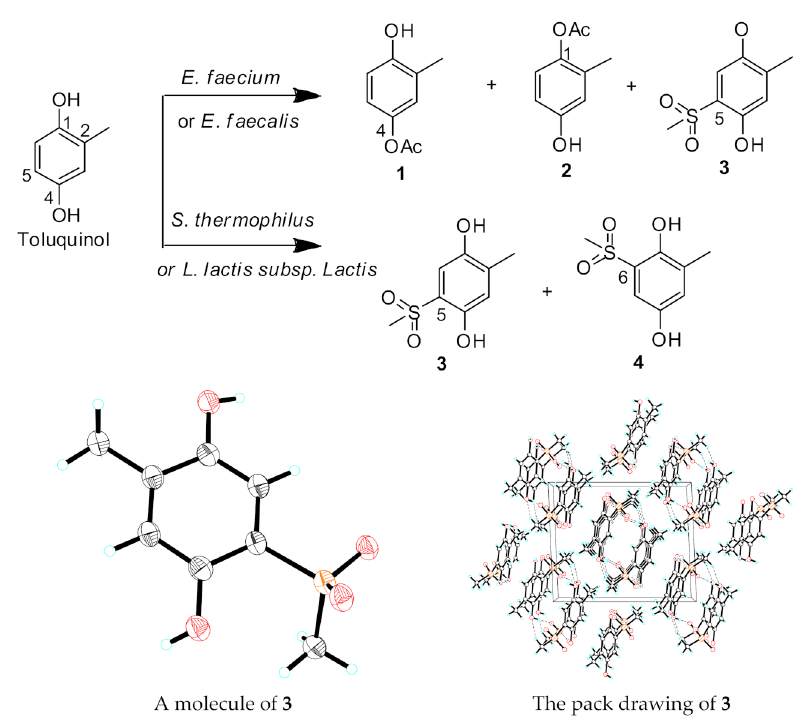
Figure 3. The four targeted metabolites ( 1 – 4 ) derived from toluquinol in four gut microbes and the single X–ray crystallographic structure of 3 . Red: oxygen; Orange: Sulfur; Blue: Hydrogen; Black: Carbon.